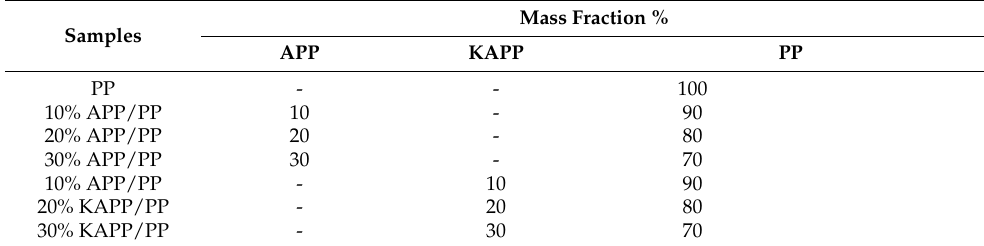
Table 3. Flame-retardant polypropylene composite